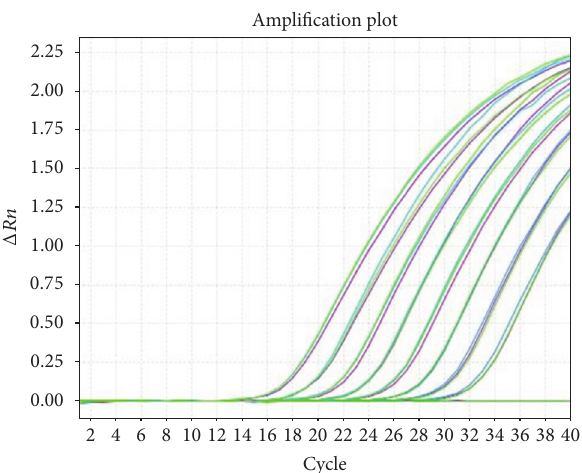
Figure 6: Limit of TaqMan PCR assay for raccoon dog detection. Nine 10-fold dilutions of purified DNA that concentration ranged from 1fg to 100 ng per microliter were tested. The reactions were performed in triplicate. The limit of detection of the PCR assay was 0.01pg ⋅𝜇 L −1